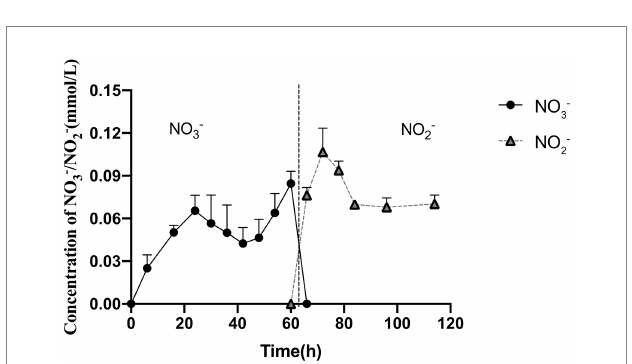
FIGURE 4 Strain 24S4–2 accumulated nitrogen intracellularly. Nitrate was accumulated intracellularly before 60 h, and nitrite was accumulated